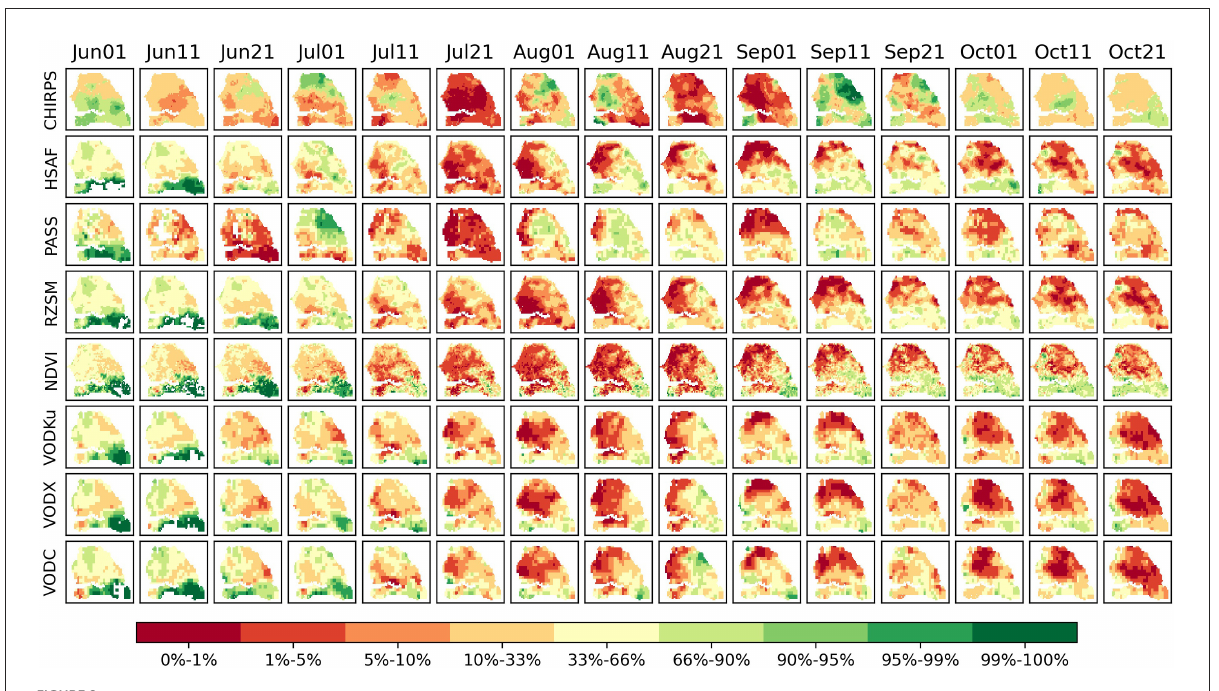
drought conditions apart from August 2014, where the fraction of drought pixels identified by the passive dataset drops to below 50% in all three land cover classes. Figure 2 shows that in the first two dekads of August, positive anomalies are observed in the rainfall datasets and are also present for a large area in the passive surface SM but to a smaller extent in the H SAF